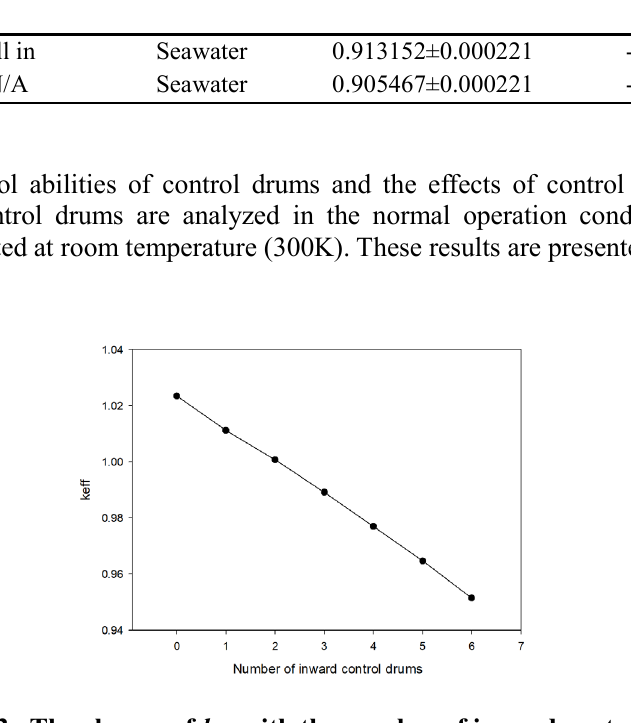
Figure 3. The change of k eff with the number of inward control drums. Table III. The effects of control ring in different cases.